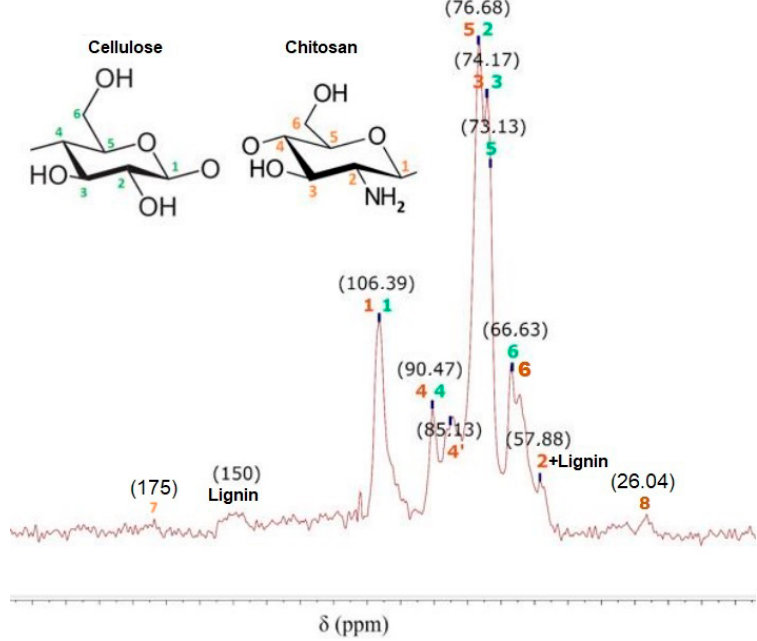
Figure 7. 13 C NMR spectrum of CMF-g-CH after copolymerization.